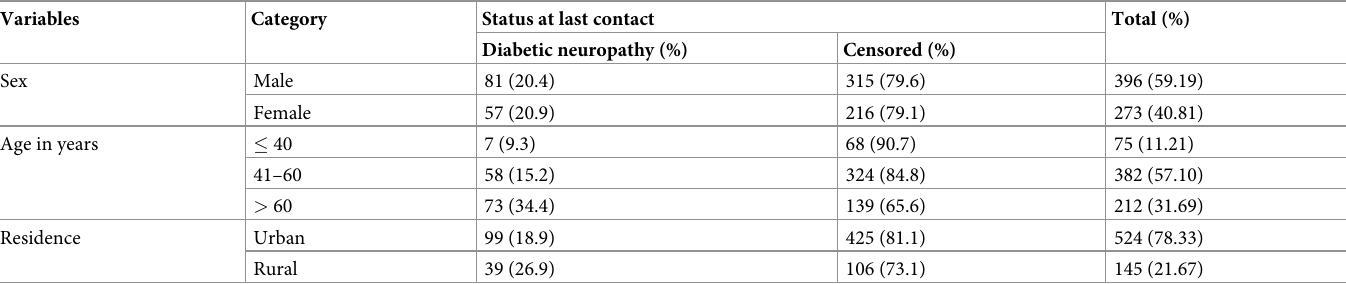
Table 1. Socio-demographic characteristics of type 2 DM patients at Amhara region Comprehensive Specialized Hospital, Northwest Ethiopia (n = 669).